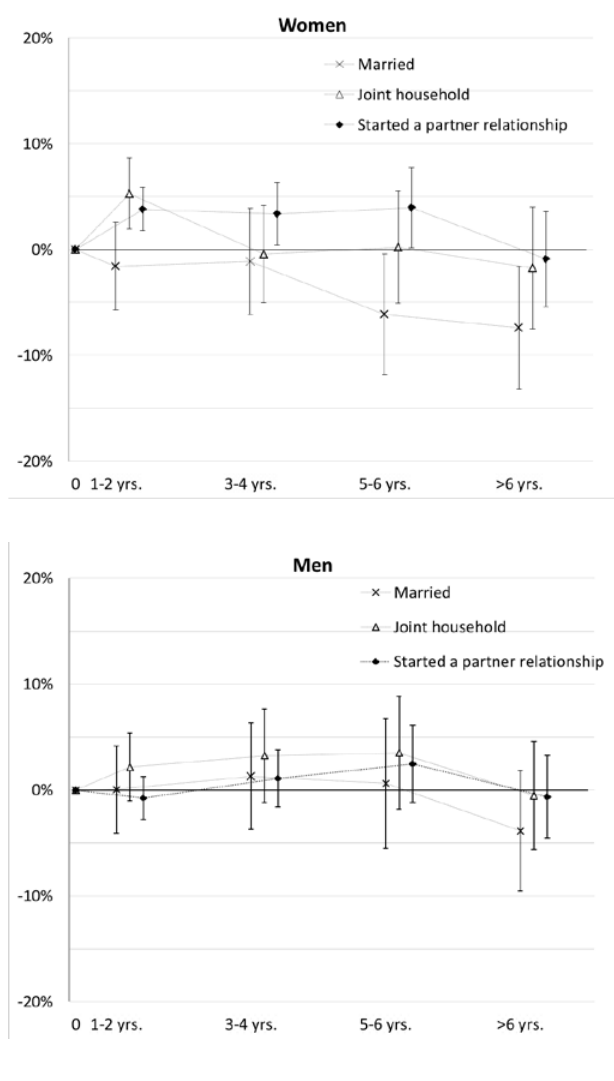
Figure 2 : Time-effects of partner relationships on social isolation (linear-probability models with fixed effects, percentage points and 95%-confidence limits)